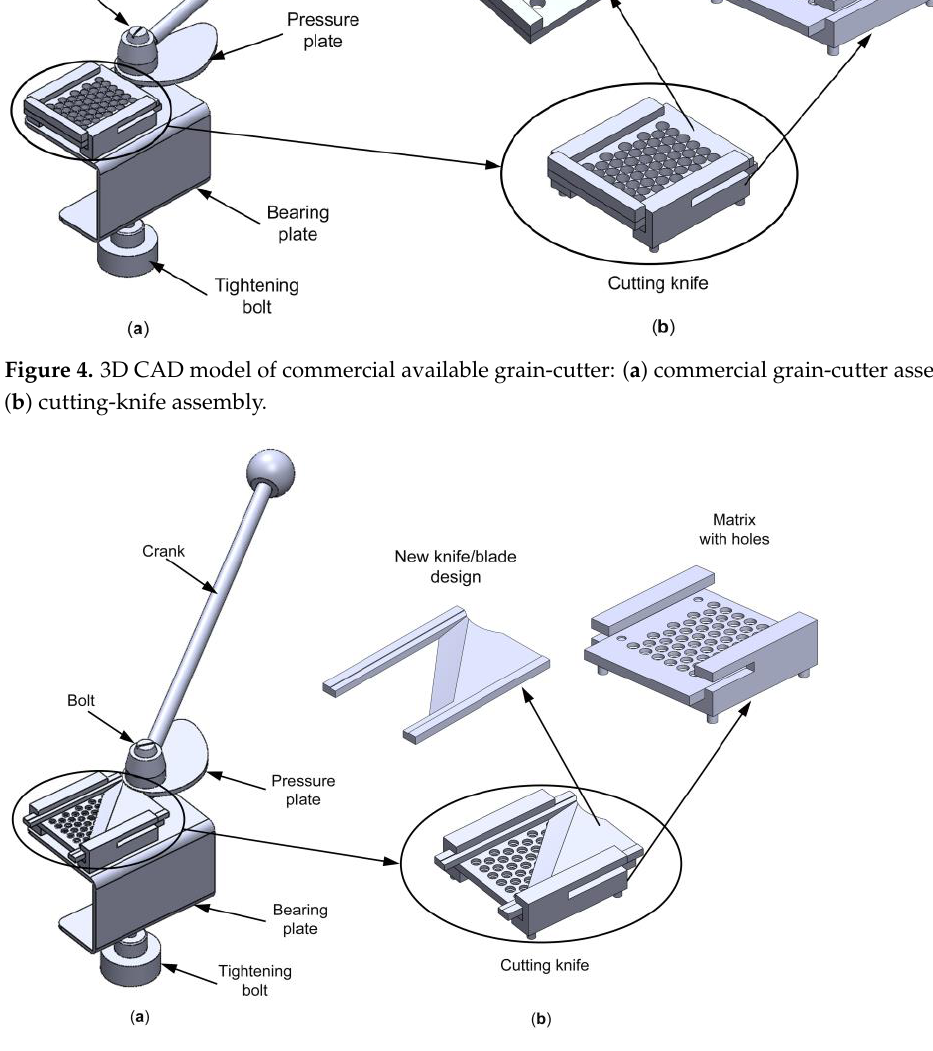
Figure 5. 3D CAD model of modified grain-cutter: ( a ) modified grain-cutter assembly; ( b ) new design of knife/blade.